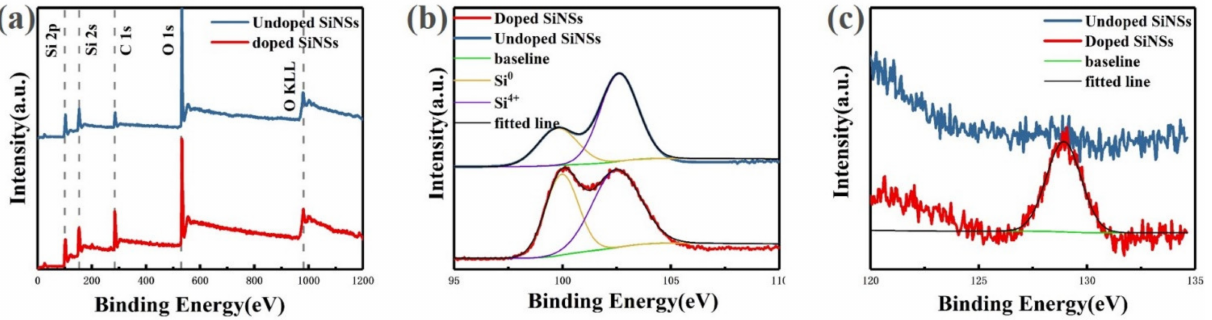
Figure 4. X-ray photoelectron spectroscopy (XPS) spectra of silicon nanosheets: ( a ) full spectra of undoped (blue line) and doped (red line) samples; ( b ) Si 2p spectra of undoped (blue line) and doped (red line) samples; ( c ) P 2p spectra of undoped (blue line) and doped (red line) samples. For undoped and doped samples, two Si 2p binding energy peaks located at 99 and 103 eV are detected which are corresponding to Si 0 state and oxidized Si 4+ state,